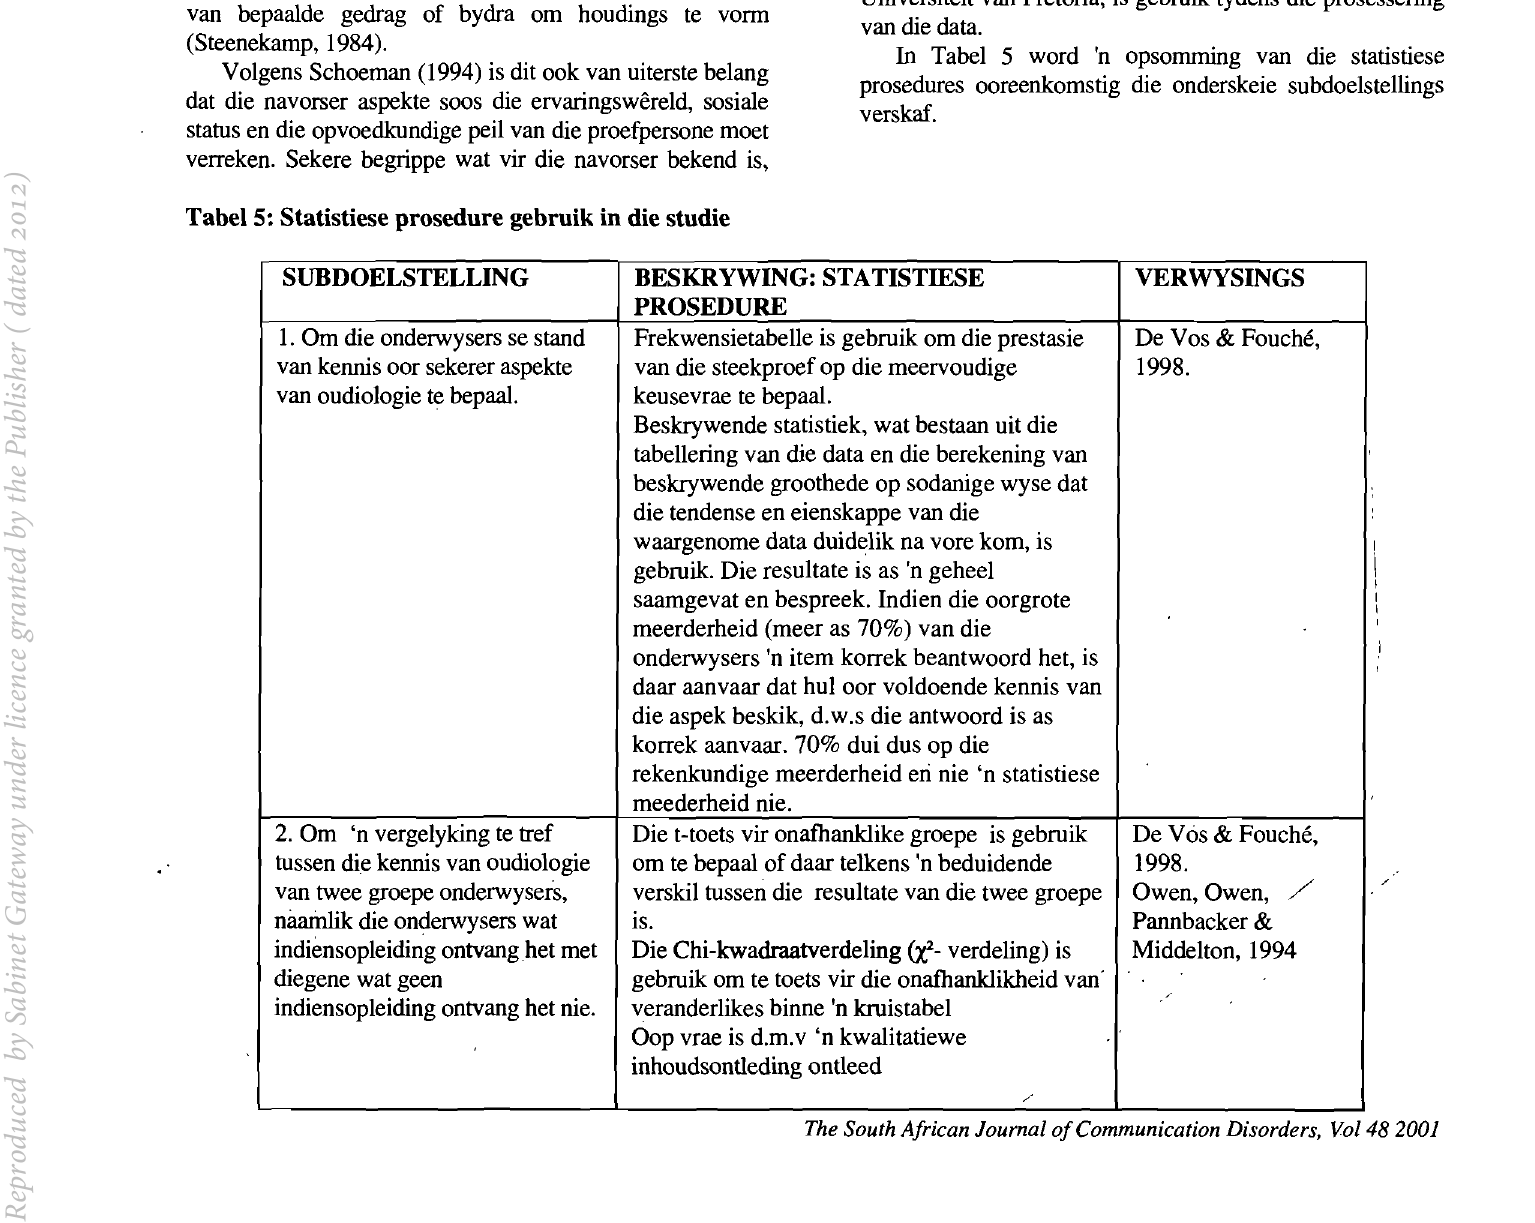
Tabel 5: Statistiese prosedure gebruik in die